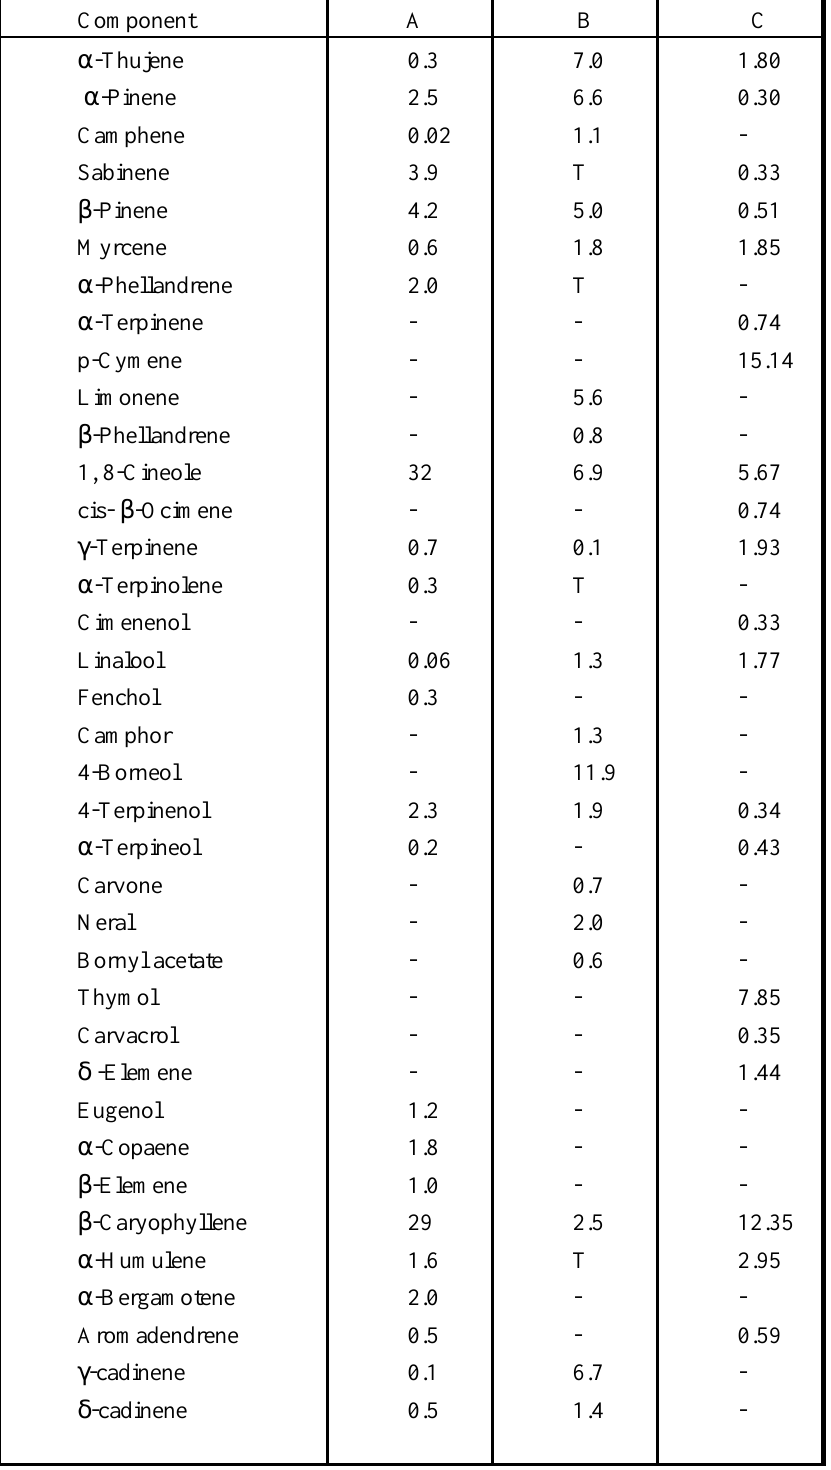
Table 1. A comparison of chemical composition of the essential oils from Hyptis sp. A = H. suaveolens ; B = H. emoryi [24]; C = H. mutabilis [22]